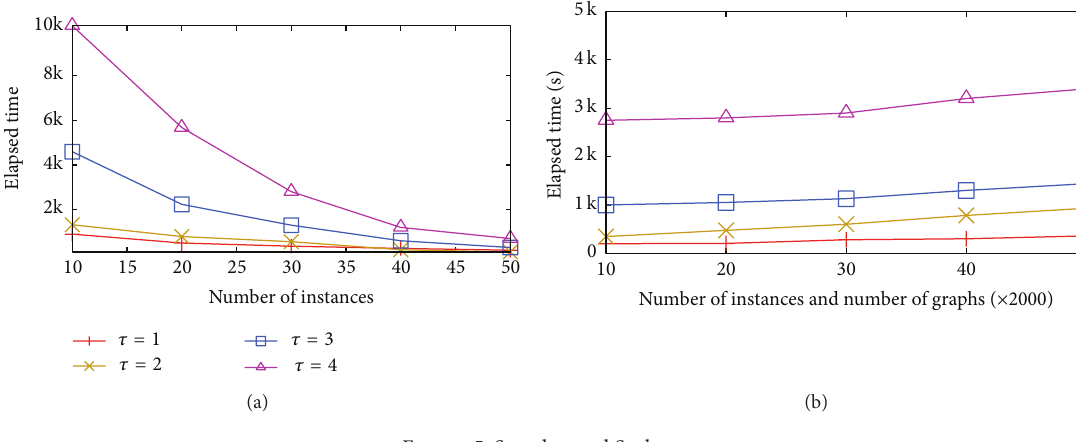
Figure 5: Speedup and